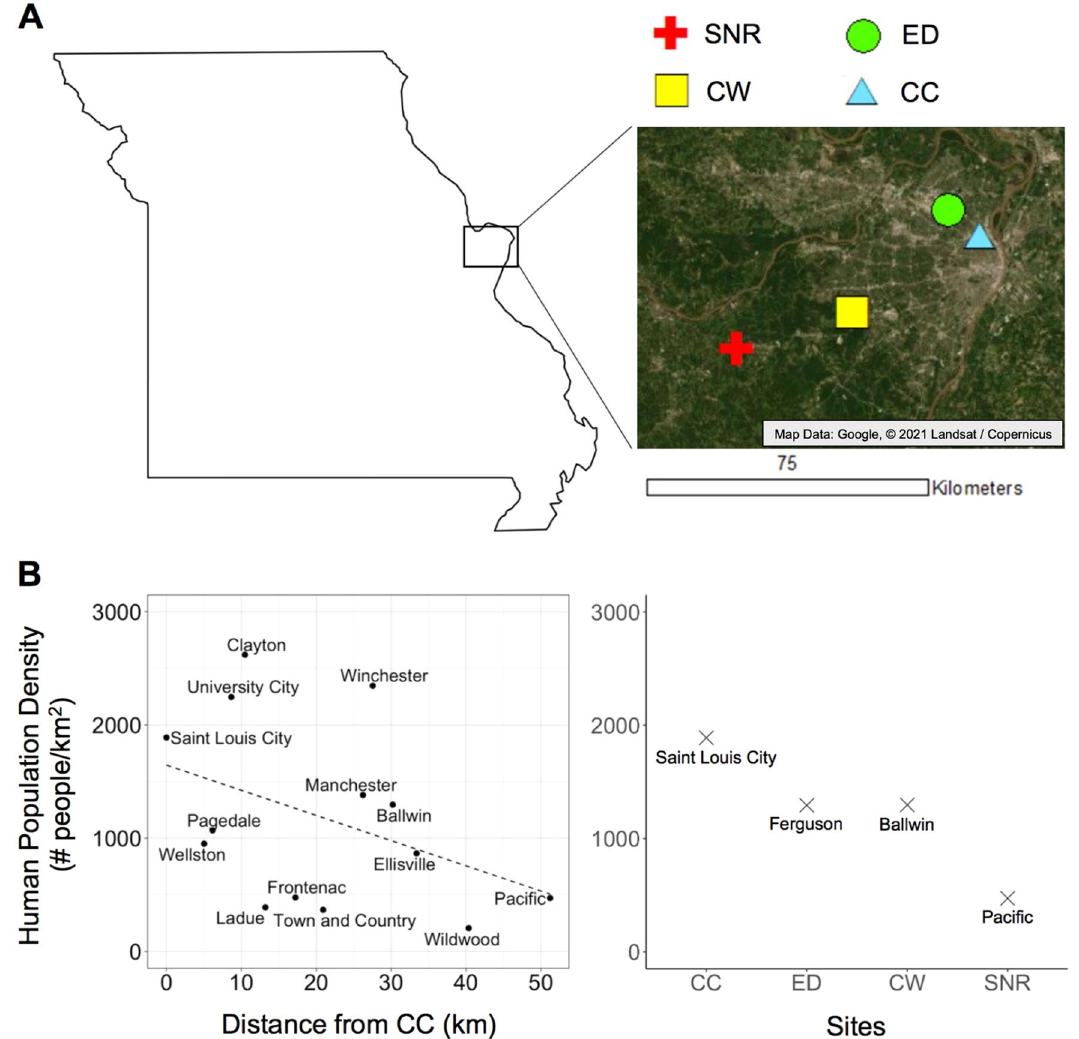
Figure 1. ( A ) Map of sampling locations. CC Calvary Cemetery, CW Castlewood State Park, ED EarthDance Farms, SNR Shaw Nature Reserve. Map generated with Google Earth 9.154.0.1 (https:// earth. google. com). ( B ) Human population density per locality. Left panel: Urban gradient depicted by human population density per locality from CC (Saint Louis City, MO) to SNR (Pacific, MO). Distance from CC is the distance from CC to the approximate midpoint of a locality that occurs along the trajectory from CC to SNR. Right panel: Human population density of each locality where a site is